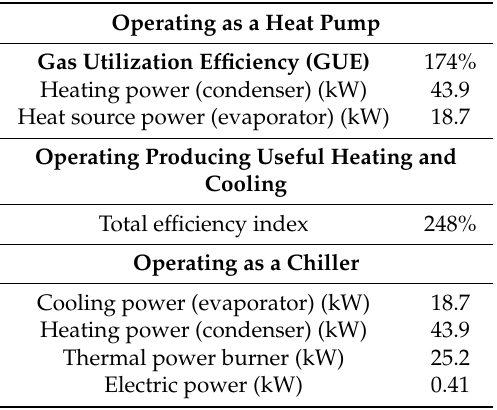
Table 2. Main technical characteristics of the absorption heat pump/chiller Robur GAHP-WS (Robur,